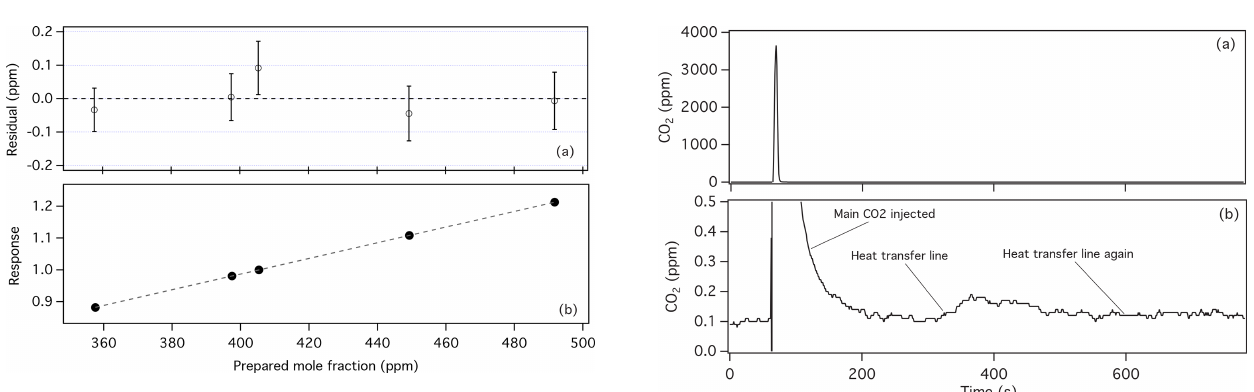
Figure 4. Measure of CO 2 passing through a ∼ 1m AT-steel trans- fer line. The peak in (a) results from 0.6cm 3 air containing 10% CO 2 injected into CO 2 -free air flowing at 0.2Lmin − 1 . Panel (b) is an expanded view of (a) , showing a second peak at ∼ 400s, which results from CO 2 driven off the tubing by